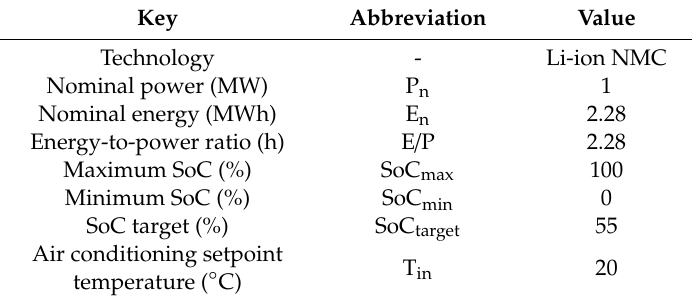
Figure 3. Yearly trend and histogram of frequency data used for simulation. Table 2. Battery energy storage system (BESS) details for the simulations.